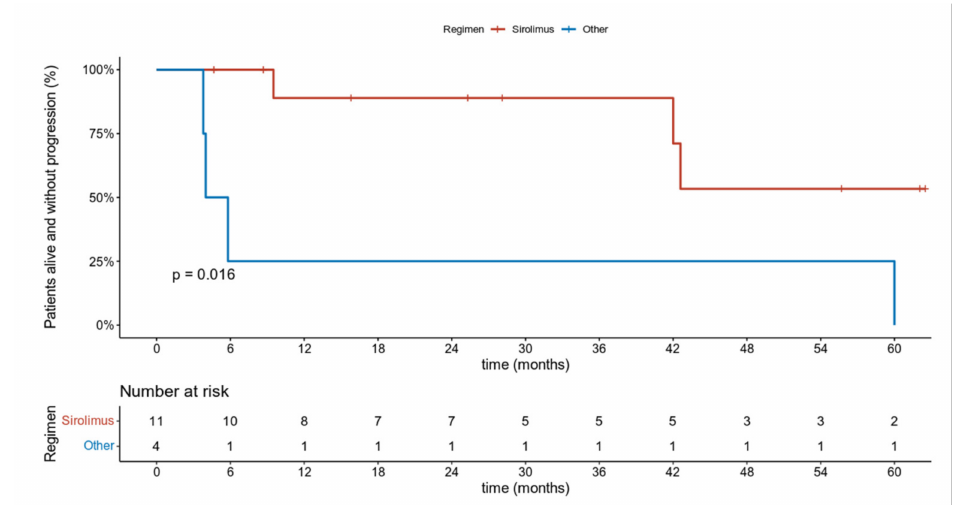
Figure 4. Progression-free survival in PEComa patients receiving sirolimus ( red line ) or chemother- apy ( blue line